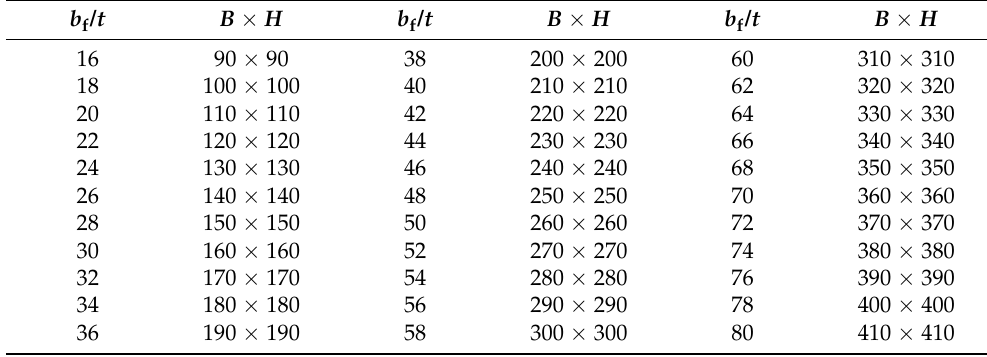
Table 4. Dimensions of SHS honeycomb specimens for parametric analysis ( t = 5, unit: